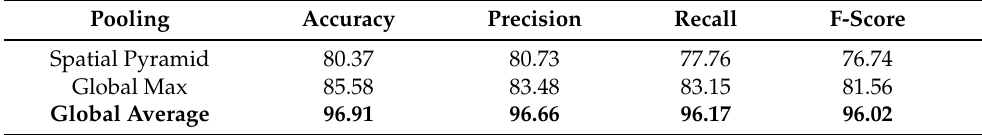
Table 5. Average recognition performance of KinectGaitNet with different pooling methods on the UPCV dataset. The best performance is shown in bold.